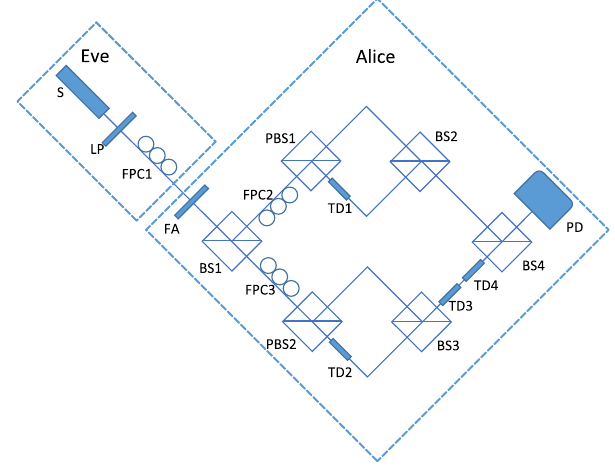
FIG. 5. Experiment setup of SIQRNG. S: laser source; LP: linear polarizer; FPC: fiber polarization controller; FA: fiber attenuator; BS: beam splitter; PBS: polarizing beam splitter; TD: time delay implemented with a 12-m fiber; PD: photon